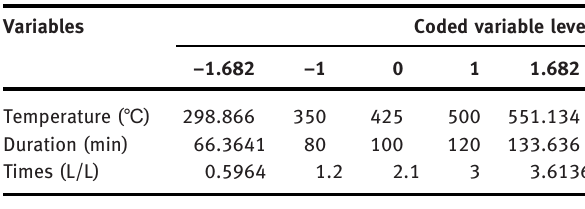
Table 3: Range of variables utilized in the experimental design (Times=Actual oxygen consumption /Theoretical oxygen